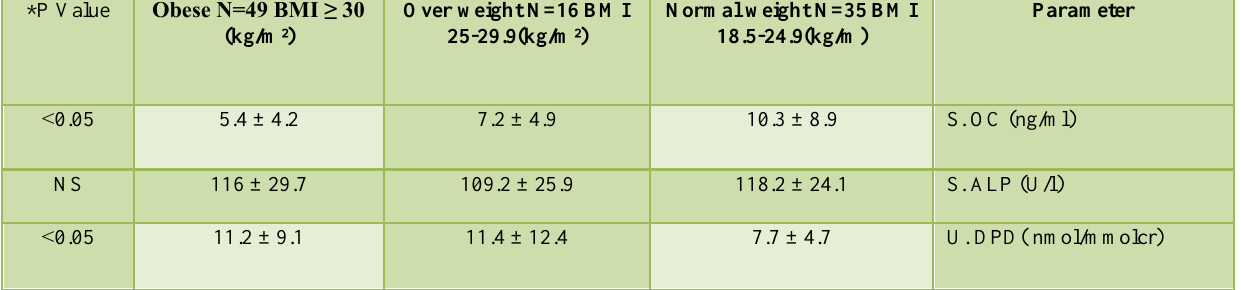
Table-1.3. the distribution of bone turn over markers among diabetic patients according to BMI.